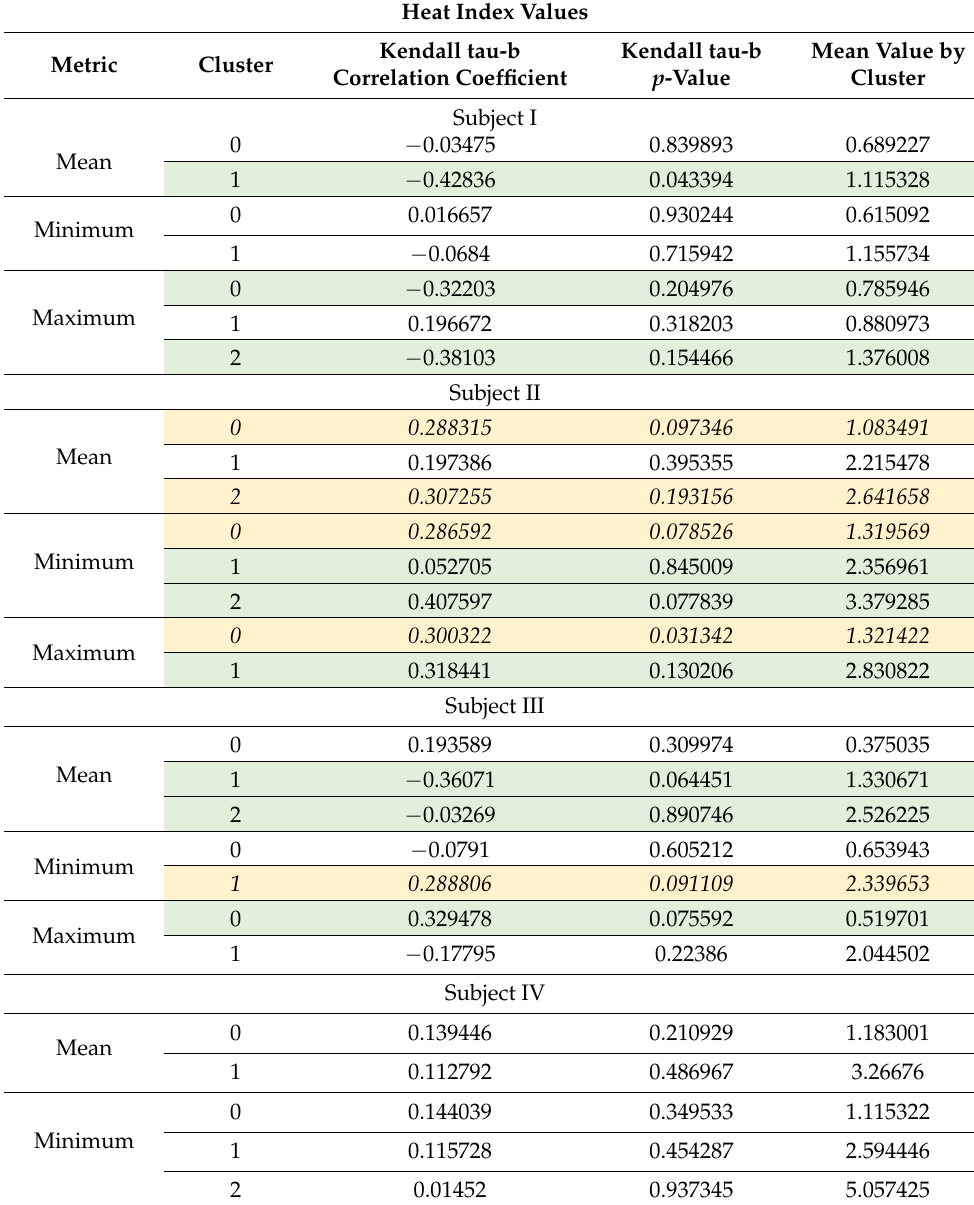
Table 6. Kendall tau-b statistical calculations of heat index by subject and